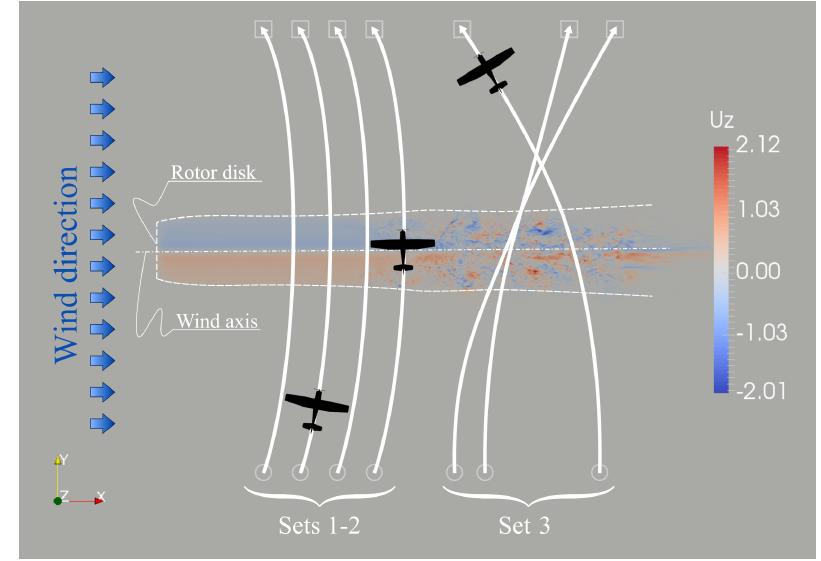
Figure 6. Scenarios scheme for a comparison of the three simulation families. The background image shows the wind velocity’s vertical component field for the OpenFOAM case ALM 21 . Aircraft silhouette is not to scale and all of the three sets investigate the aircraft behaviour on the whole extension of the wake downwind of the